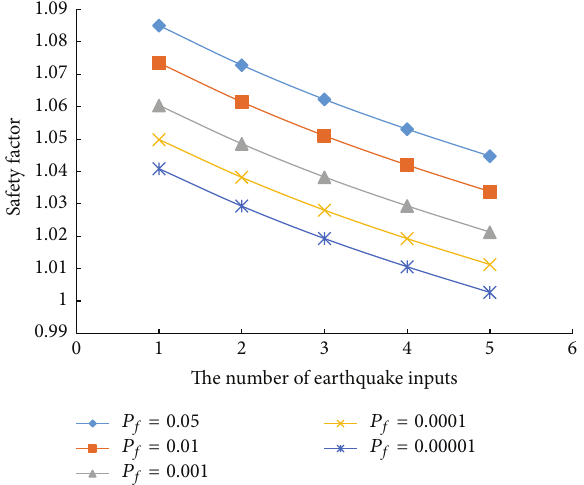
Figure 19: Curves of the number of earthquake inputs and safety factors under different failure